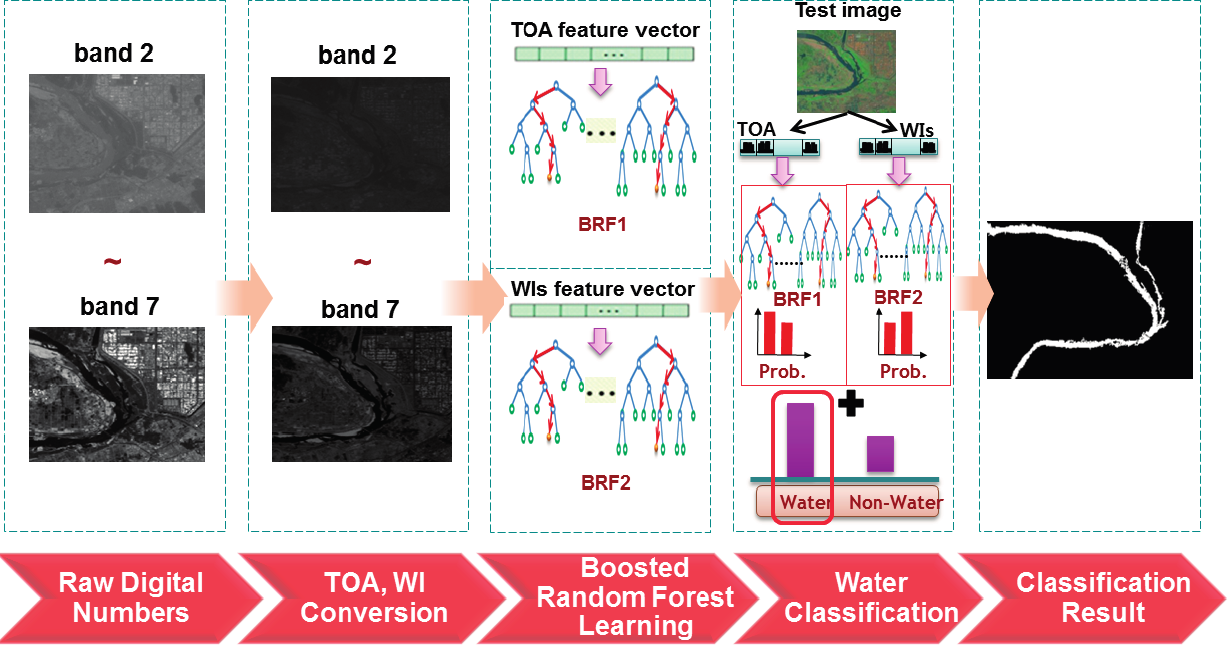
Figure 1. The block diagram of the water body classification procedure using OLI sensor